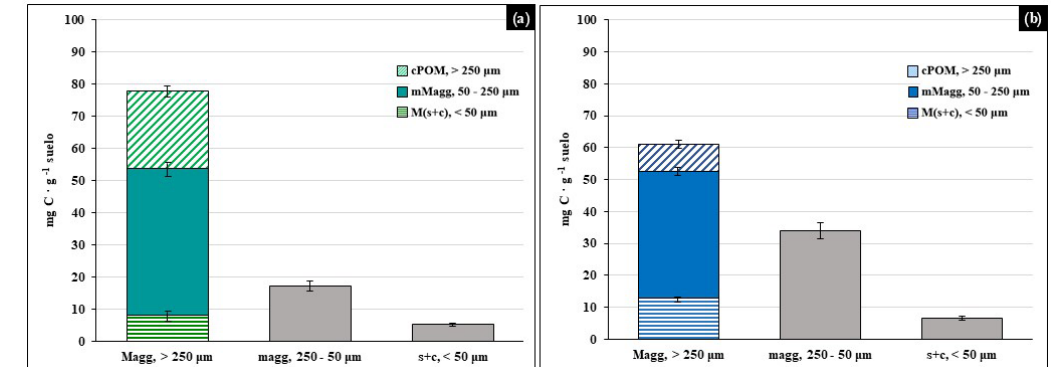
Figure 4. Distribution of organic C in stable aggregates and individual particles in soil under OPM (a) and CM (b) . Magg: Macroaggregates; magg: microaggregates; mMagg: microaggregates within macroaggregates; s + c : silt + clay fraction; cPOM: coarse particulate organic matter > 250µm and sand particles. The error bars represent the standard error, which is the standard deviation divided by the square root of the sample size. All aggregate fractions are significantly different ( p < 0 . 05) between OPM and CM, with the exception of s + c and mMagg.